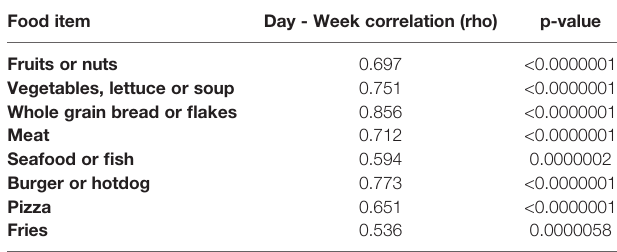
TABLE 4 | Associations between dietary items and semen